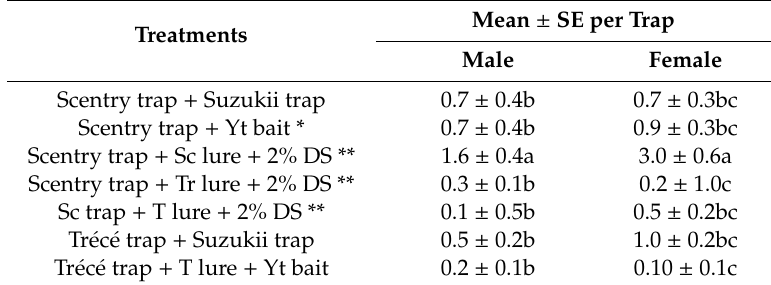
May 2016 in Tallahassee,